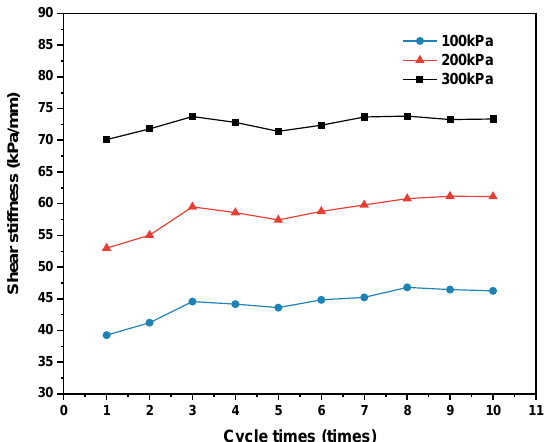
Figure 20. Shear stress – shear displacement relationship curves under different vertical stresses.